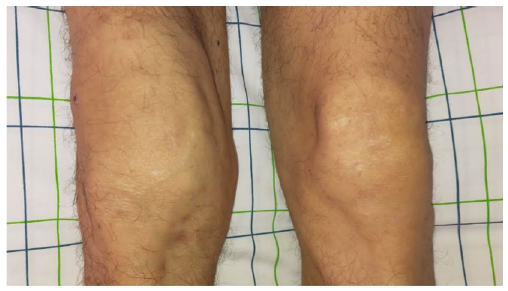
Figure 1: Arthritis of the right